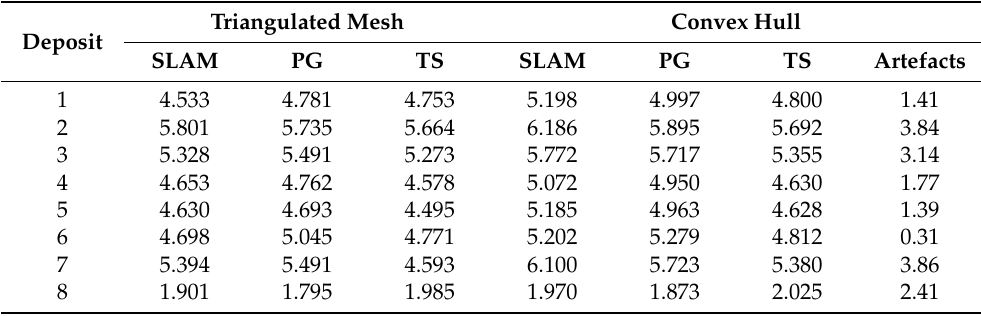
Table 2. Surface areas of each layer by method and modelling technique in m 2